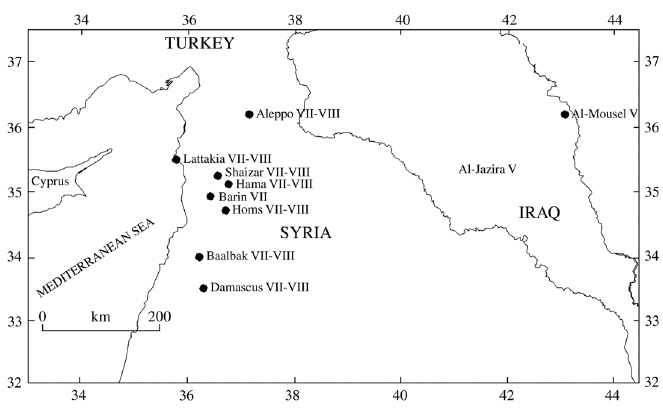
Fig. 10. Map of intensity distribution for June 29, 1170